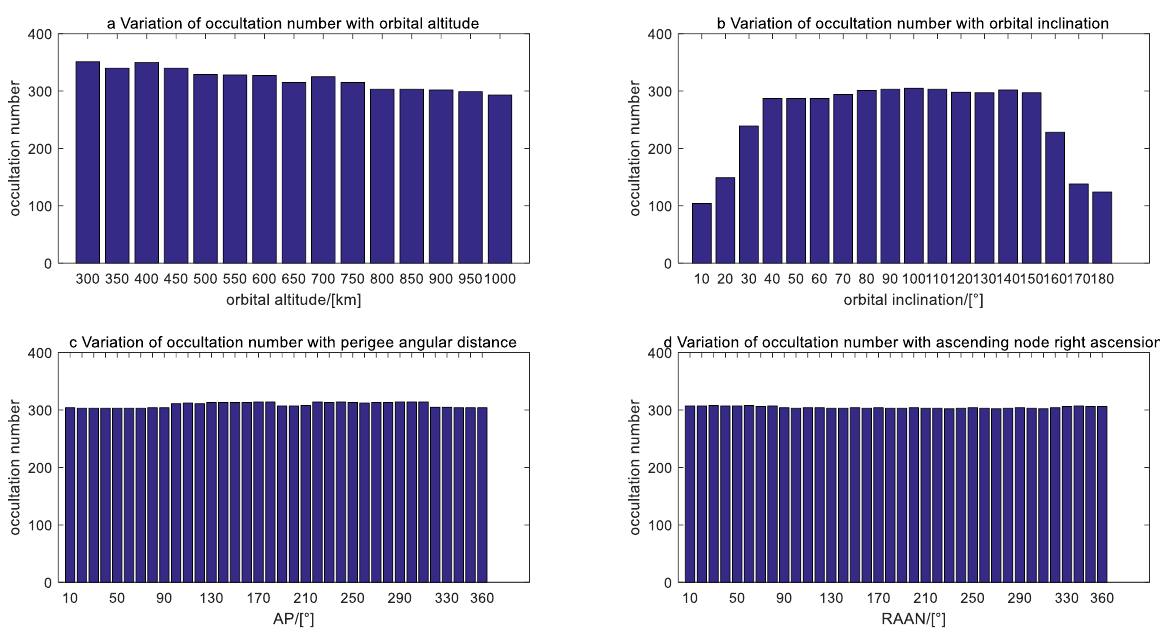
Figure 1. Variation in the number of occultation events with changes in the orbital parameters. Based on an analysis of the impact of the above orbit parameters on the number of occultation events, when designing the orbit of the LEO satellite, it should be considered that more occultation events can be obtained when I is in the range of 40–150 ◦